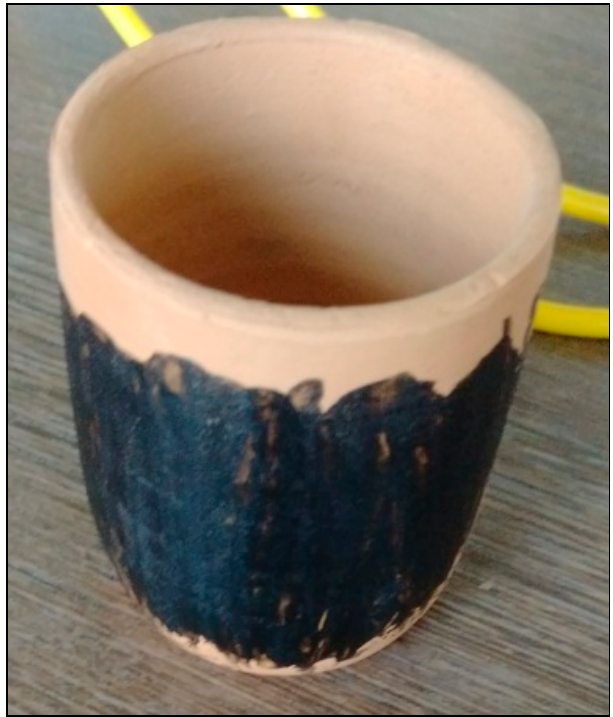
Figure 3. Ceramic separator with an electrode coated with graphene air-cathode assembly